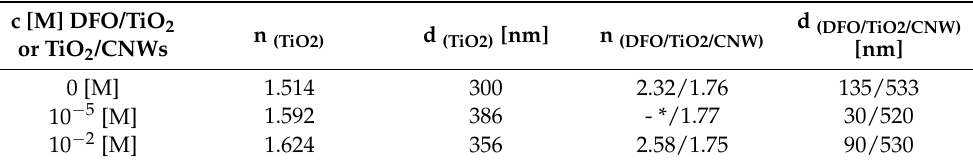
Table 1. Ellipsometrically estimated properties of DFO/TiO 2 [21] films related to DFO/TiO 2 /CNW films with different concentrations of DFO dye. c [M] DFO/TiO 2 n (TiO2) d (TiO2) [nm] n (DFO/TiO2/CNW) or TiO 2 /CNWs